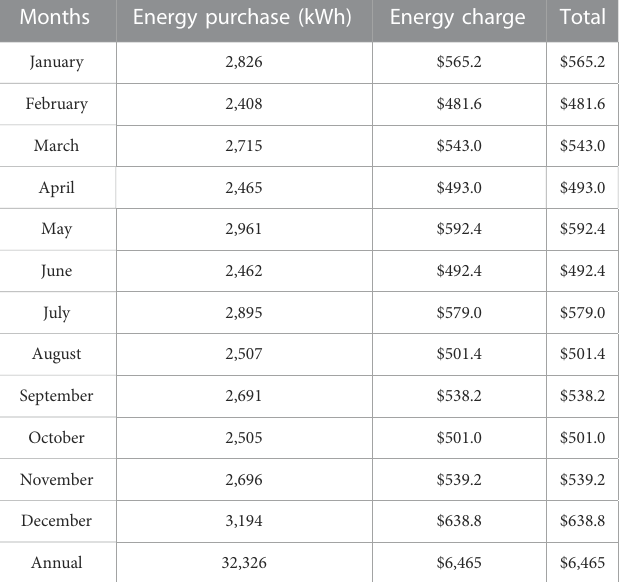
TABLE 8 Energy report for the base case. TABLE 9 Comparison of the base case with the proposed